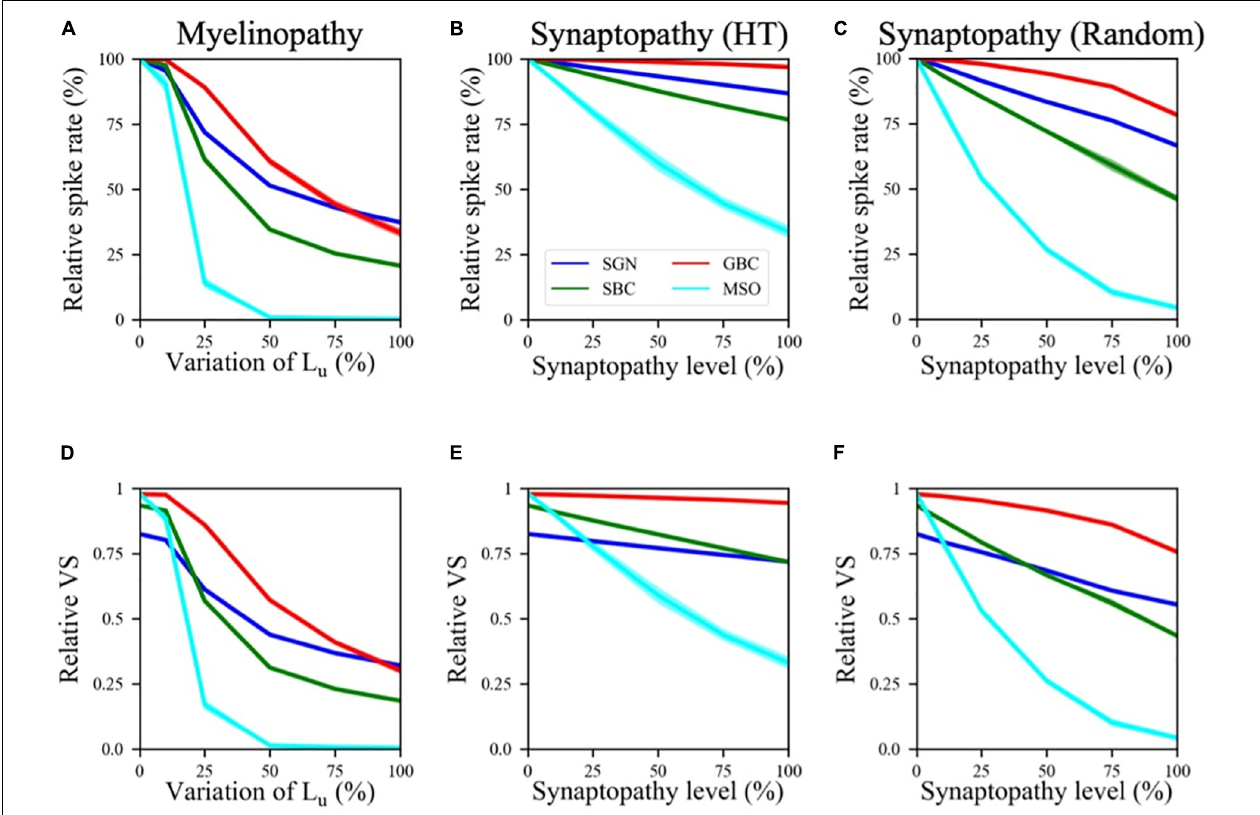
FIGURE 2 | Spike activity and dynamics in all cell populations was disrupted with higher levels of peripheral auditory deficiencies. Relative spike rate (A–C) and relative VS (D–F) measurements of different cell populations (SGN, SBC, GBC, and MSO) in response to 200 Hz, 50 dB sound stimulus for different peripheral neuropathy conditions: myelinopathy (A,D) , synaptopathy at HT (B,E) and random synaptopathy (C,F) . In myelinopathy, 0% variation of L u represents a circuit with a homogeneous population of SGNs with 10 µ m long L u , and 100% variation of L u represents a circuit with a heterogeneous SGN population with 10 µ m ≤ L u ≤ 20 µ m. In both synaptopathy scenarios (HT and random), 0% synaptopathy indicates all IHC-SGN synapses are intact. Synaptopathy level of 100% means all IHC-HT SGN synapses are deficient in HT synaptopathy, whereas the same number of synapses are randomly removed in random synaptopathy (1/3rd of all synapses). In all conditions, increasing the degree of the deficiency (myelinopathy or synaptopathy) decreased relative spike rates and relative vector strength (VS, see “Materials and Methods” section) of all cell types, yet with different slopes for different scenarios. However, in all scenarios, decreases were more pronounced for MSO cells.